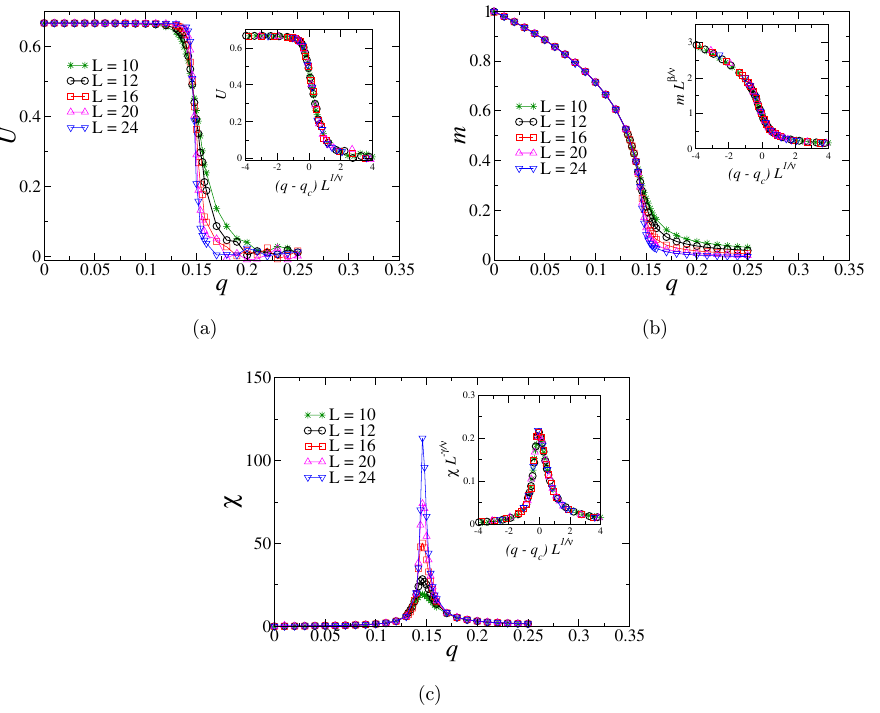
Fig. 5. Binder cumulant U (a), order parameter m (b) and susceptibility (cid:5) (c) as functions of the independence probability q for the symmetric case ( g ¼ 1 = 3 ) on 3D cubic lattices for di®erent lattice sizes L . In the inset, we exhibit the corresponding scaling plots. The estimated critical quantities are q c (cid:3) 0 : 146 , (cid:2) (cid:3) 0 : 32 , (cid:3) (cid:3) 1 : 23 and (cid:4) (cid:3) 0 : 62 . Results are averaged over 300, 200, 150, 120 and 100 samples for L ¼ 10 ; 12 ; 16 ; 20 and 24,